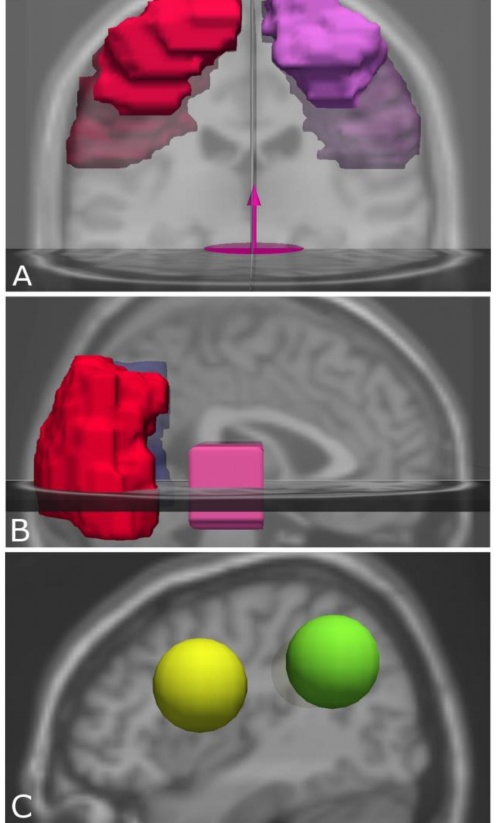
Figure A3. Definition of regions of interest (ROIs) for the CST ( A ), covering the precentral gyrus as well as the cerebral peduncles; for the OR ( B ), covering the visual cortex and the lateral geniculate nucleus (LGN); and for the AF ( C ), covering the regions of the horizontal part and the descending portion of the